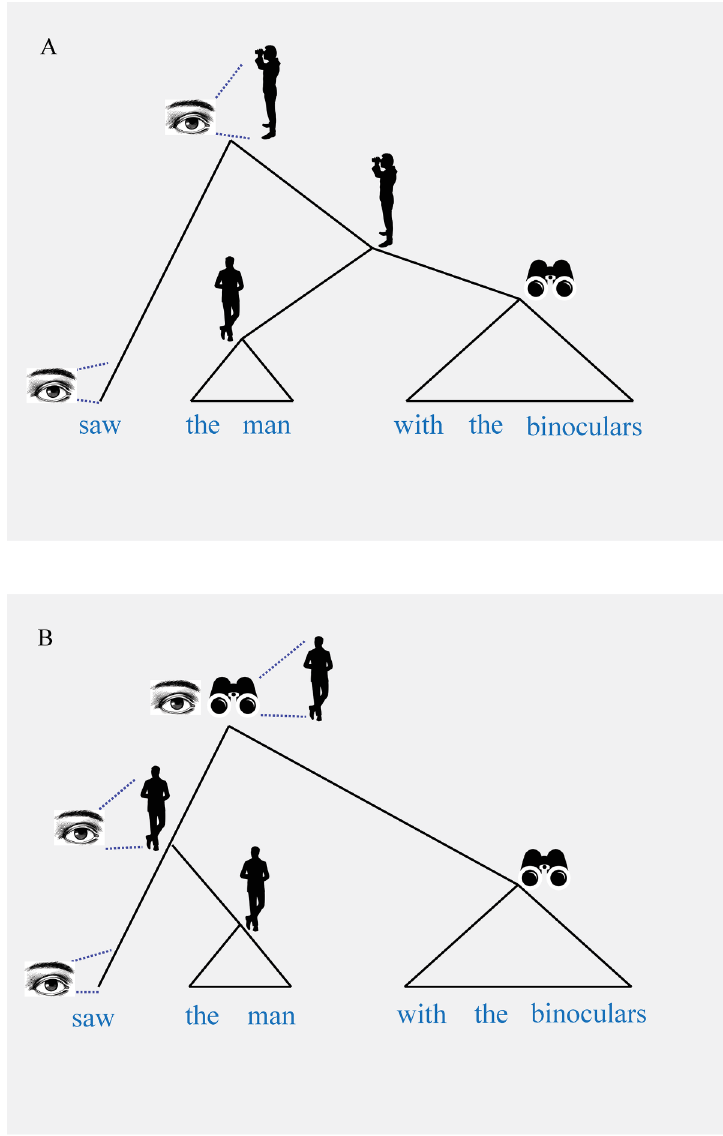
Fig 1. Meaning depends on syntactic structure. In Fig 1A, the phrase consists of the verb saw and the object of the verb the man with the binoculars , itself consisting of the noun phrase the man and a modifying prepositional complement with the binoculars . First, the modifying complement and the noun phrase are combined in what will be the object of the verb. The phrase in Fig 1B consists of a verb ( saw ), the object of the verb ( the man ), and an adjunct ( with the binoculars ), the means by which the man is seen. First, the object is combined with verb, and then this result is combined with the